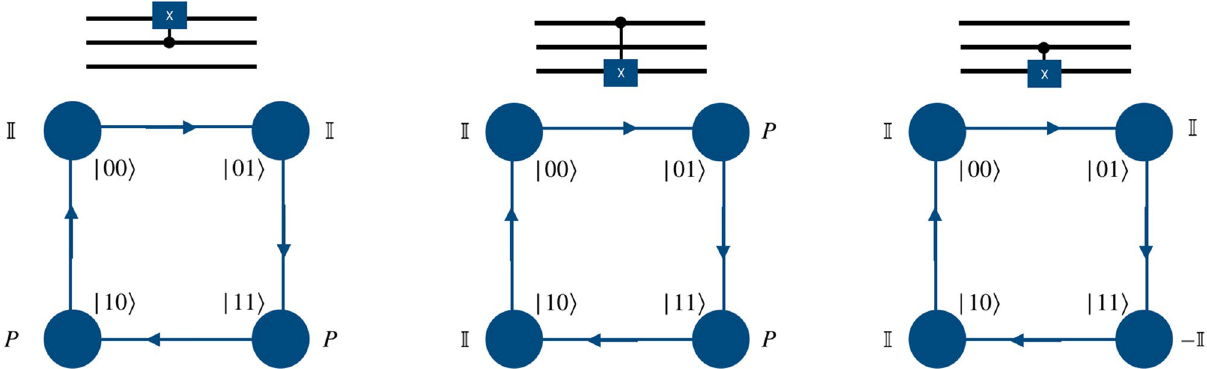
Figure 9. Schematic illustration of the implementation of the controlled-Z gate on a three-qubit system. The operation P is a phase operation of the form ( e i π I